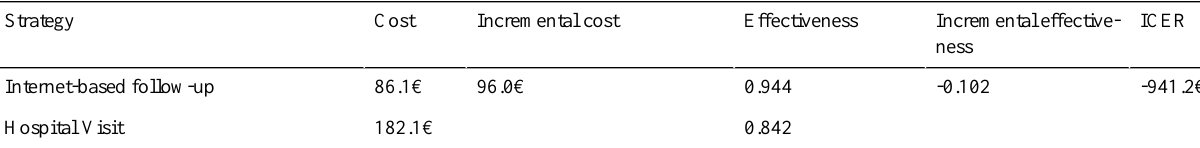
Table 3. Costs per infant and ICER of Internet-based follow-up for prevention of ED visits in the first month of life.